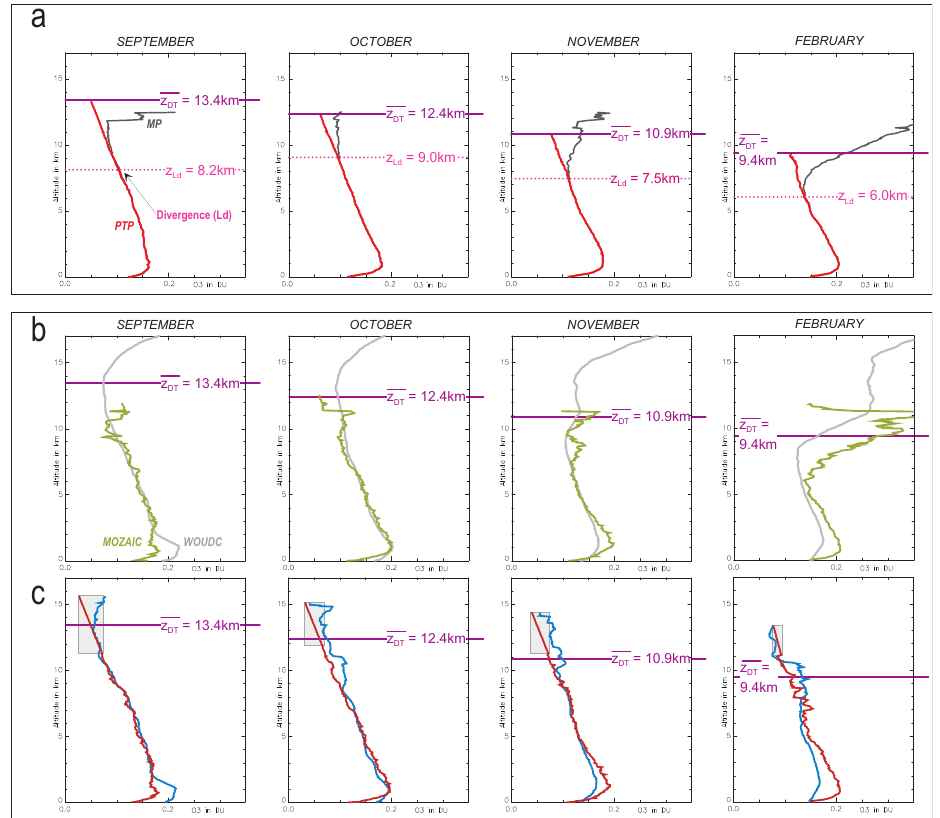
Fig. 2. Methodology (a) and validation (b, c) illustrated with data sets of MOZAIC over Japan and WOUDC sondes at Tateno (1994– 2006) focusing on September, October, November and February profiles (left to right) with various z DT (purple horizontal line) on a monthly averaged basis. (a) , using the full MOZAIC data set MP ( O 3 ,z,m ) with z = [ z 0 ,z top ] (black) and PTP ( O 3 ,z,m ) with z = [ z 0 ,z DT ] (red). The altitude where MP ( O 3 ,z,m ) diverges from PTP ( O 3 ,z,m ) is defined as z Ld , the dotted pink line. (b) , using coincident data sets MP ( O 3 ,z,m 0 ) (green – MOZAIC) and WP ( O 3 ,z,m 0 ) (grey – WOUDC). (c) , using only tropospheric data sets between z 0 and z DT of the coincident data sets MPTP ( O 3 ,z,m 0 ) (red – MOZAIC) and WPTP ( O 3 ,z,m 0 ) (blue – WOUDC). The impact of the Mfit s filling is highlighted in the panels by grey-shaded rectangles. The horizontal axis is O 3 expressed in DU and the vertical axis is altitude in kilometres.